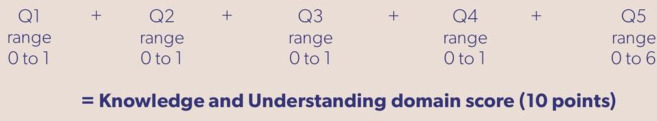
Formula for computing the knowledge and understanding score.Reprinted from www.capl-eclp.ca/capl-manual under a CC BY license, with permission from Healthy Active Living and Obesity Research Group, original copyright 2017.